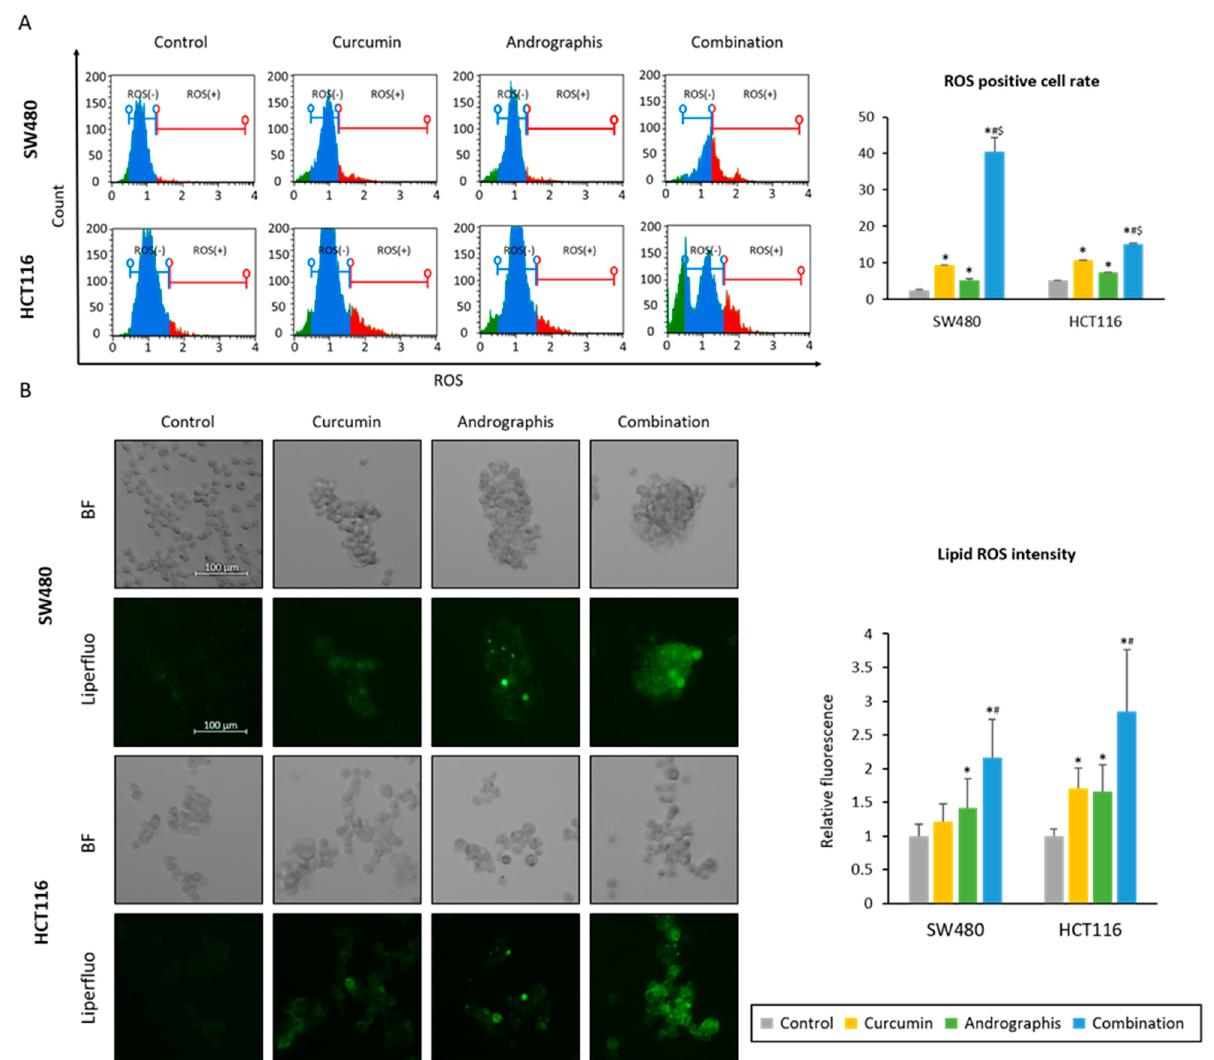
Figure 4. Curcumin and andrographis combination induced ferroptosis via intracellular accumulation of ROS and lipid peroxidases. ( A ) Representative images of the cells undergoing oxidase stress in SW480 and HCT116. The average (column) ± SD is indicated (*; p -value < 0.05 vs. control, #; p -value < 0.05 vs. curcumin, $; p -value < 0.05 vs. andrographis). ( B ) Representative images of the Liperfulo assay in SW480 and HCT116 following treatment with curcumin, andrographis, and their combination for 16 h using a fluorescent microscope under 200× magnification with a 488 nm/550 nm excitation filter (scale bar = 100 μ m). The average (column) ± SD is indicated (*; p -value < 0.05 vs. control, #; p -value < 0.05 vs. curcumin, $; p -value < 0.05 vs. andrographis). Cur: curcumin, andro: andrographis .